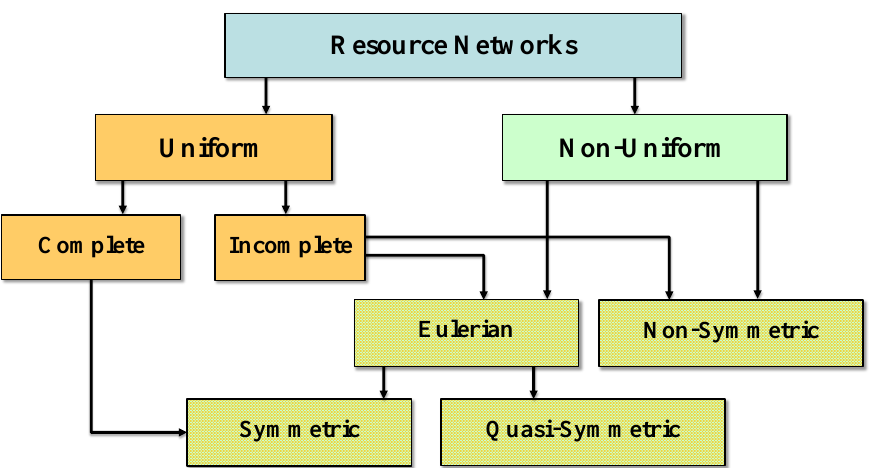
Figure 2. Classification of networks by total throughputs of vertices.